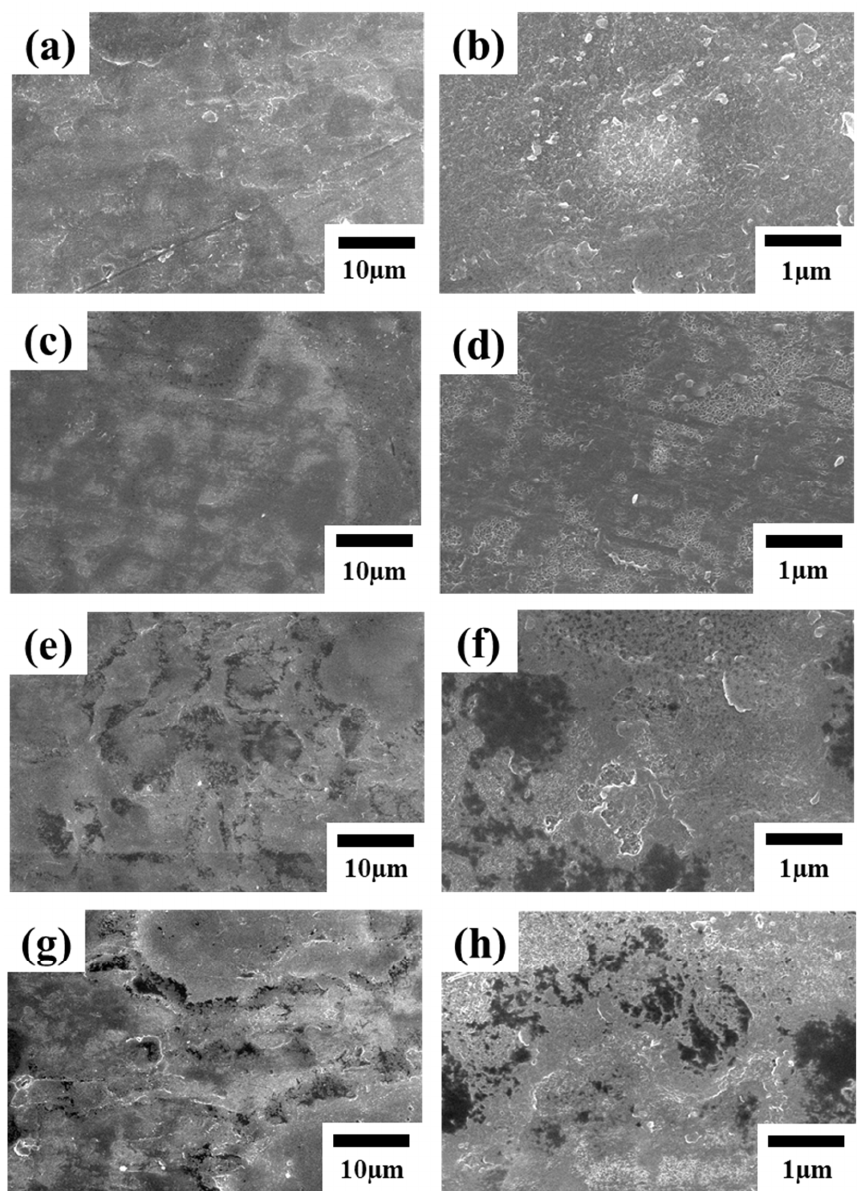
Figure 2. Surface morphology of LZ91 Mg alloy after acid pickling pretreatment for ( a , b ) 30 s, ( c , d ) 60 s, ( e , f ) 90 s, and ( g , h ) 120 s. The surface roughness results for 3D white light interferometry are shown in Figure 3. The SEM images show that the surface is similar to a 3D white light diagram, with an average surface roughness between 0.573 μ m and 0.421 μ m. The roughness decreases when the specimen is immersed for more than 30 s because the β phase corrodes more